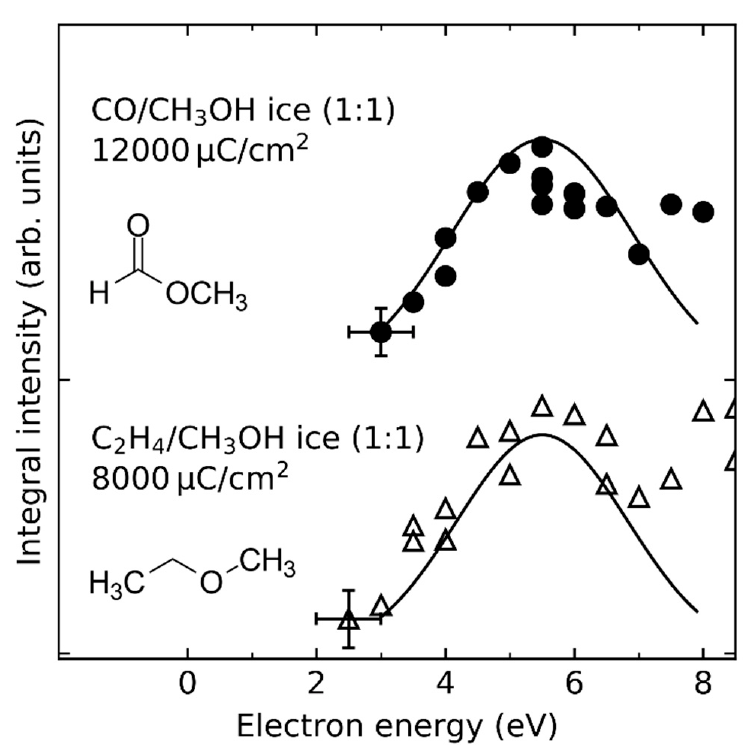
Figure 19. Energy dependences for the formation of methyl formate in CO/CH 3 OH (1:1) mixed ices, and of ethyl methyl ether in C 2 H 4 /CH 3 OH (1:1) mixed ices after electron exposures of 12,000 and 8000 µ C/cm 2 , respectively. The solid lines serve as a guide to the eye. Upper data are adapted from Ref. [26] with permission from the PCCP Owner Societies. Lower data are adapted with permission from Ref. [32]. Copyright 2019 American Chemical Society. Data for shorter exposures over a wider energy range are presented in Figure 18b.